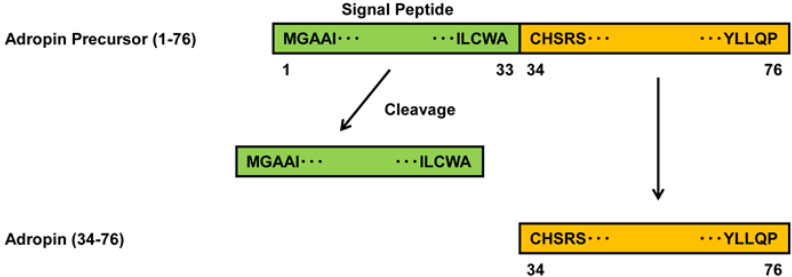
Figure 1. Biosynthesis of adropin. Adropin precursor protein consisting of 76 amino acids produces the 43 amino acid adropin by the cleavage of a 33 amino acid signal peptide.